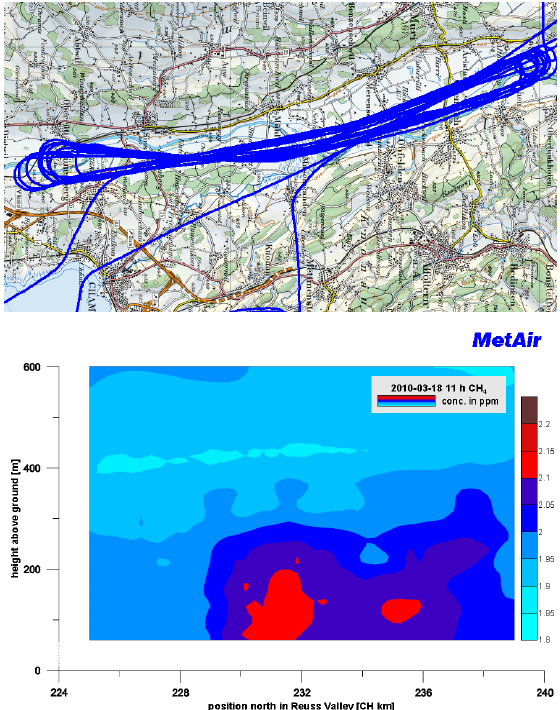
Figure 6: Flight along a south-north cross section of about 16 km length at altitudes between 600 mAGL down to 50 mAGL. North is on the right-hand side on the map (Source: Bundesamt für Landestopografie, via on-board moving map Fugawi) and on the cross section showing the vertical distribution of CH 4 along the transects (col- our scale from 1.8 to 2.2 ppm)